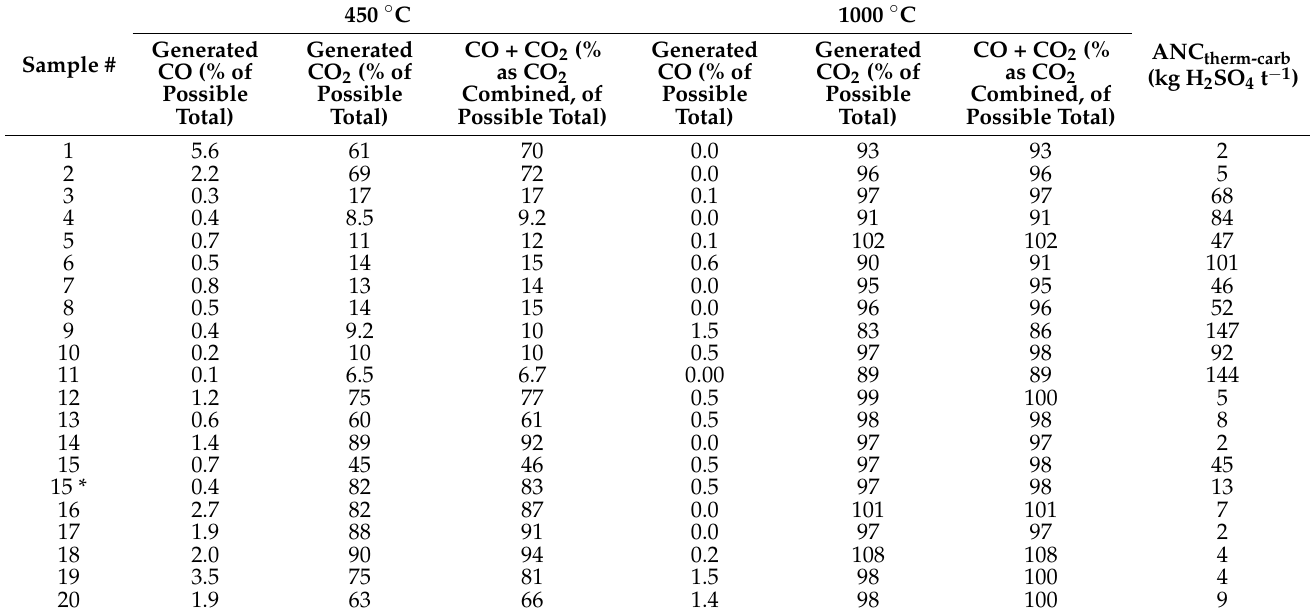
Table 6. Thermal decomposition CO and CO 2 data for the mine project samples and ANC therm-carb .